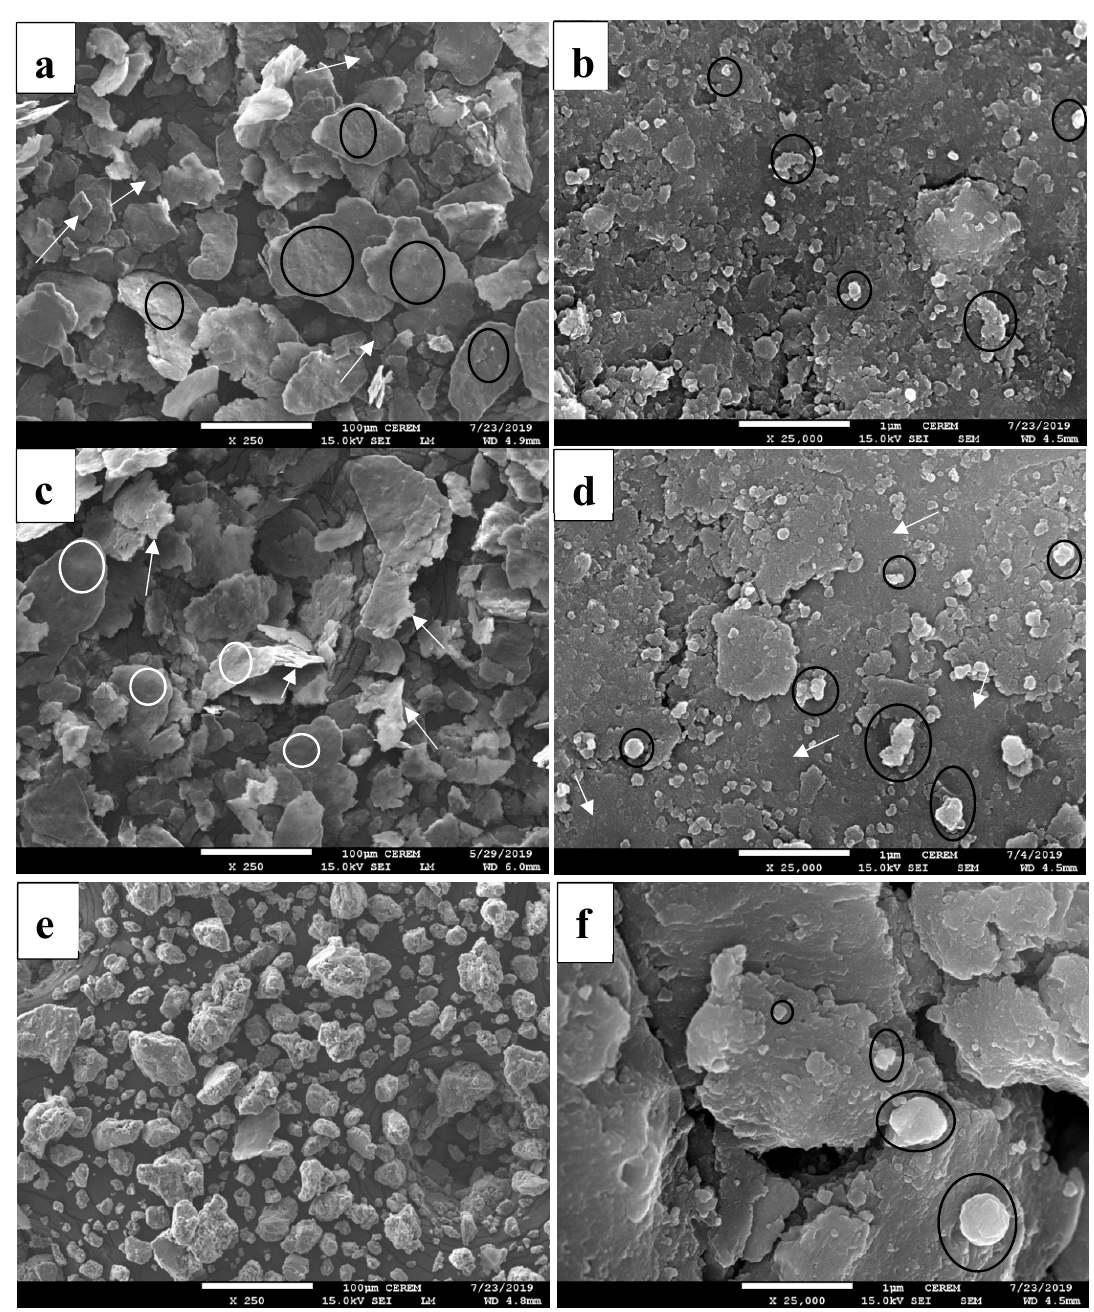
Figure 2. FESEM images for powder produced by ( a , b ) two-speeds, ( c , d ) three-speeds-last down, and ( e , f ) three-speeds all up.